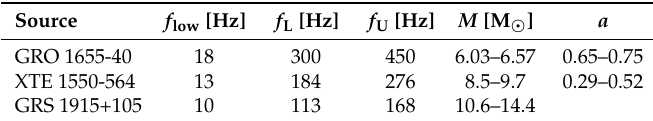
Table 3. The limits on mass M , given by optical measurements, and dimensionless spin a , given by spectral continuum fits, are presented along with the values of measured twin 3:2 HF QPOs for the three microquasars GRS 1915+105, XTE 1550-564 and GRO